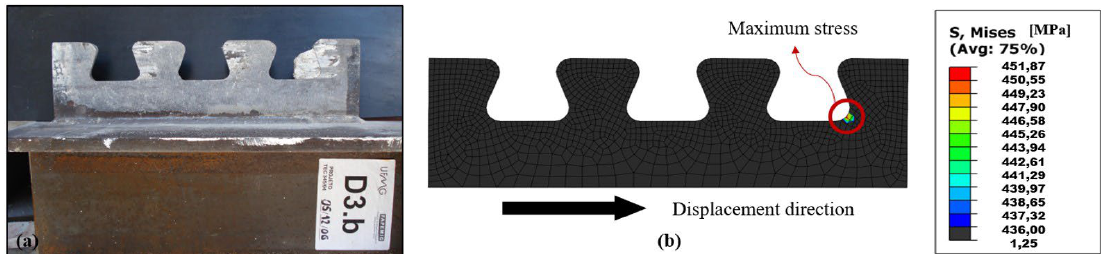
Figure 16. (a) Shear connector after tests; (b) stresses in numerical model (group D3).